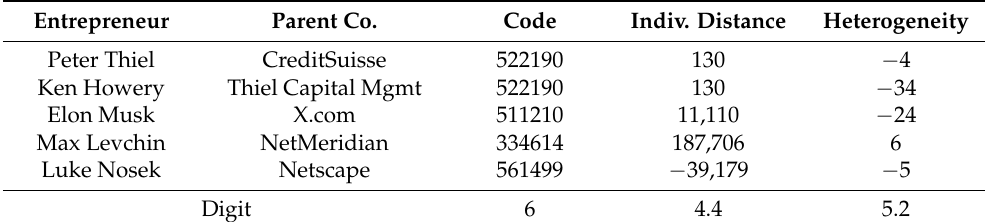
Table 6. The PayPal